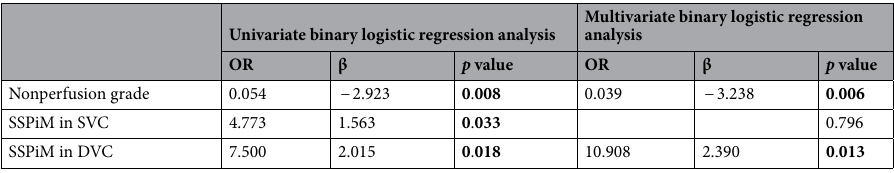
Univariate binary logistic regression